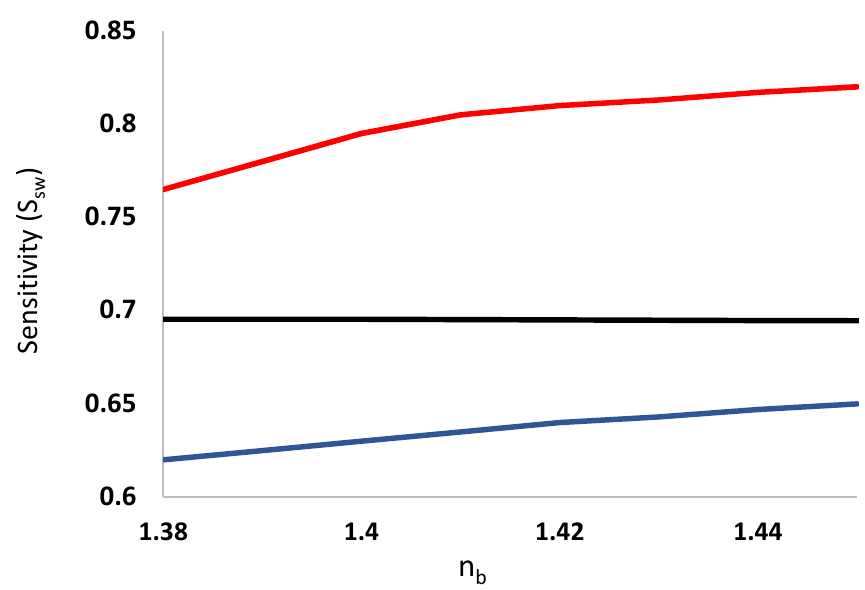
Figure 12. The sensitivity of the slot waveguides versus the refractive index of analyte. The red curve indicates the conventional slot waveguide with 200 nm waveguide width, 100 nm slot width and 220 nm waveguide height. The blue curve indicates the ridge slot wavguide which has the same dimension as conventional slot waveguide with an unetched height of 20 nm. The black curve indicates our proposed SW in a tapered DSCF.